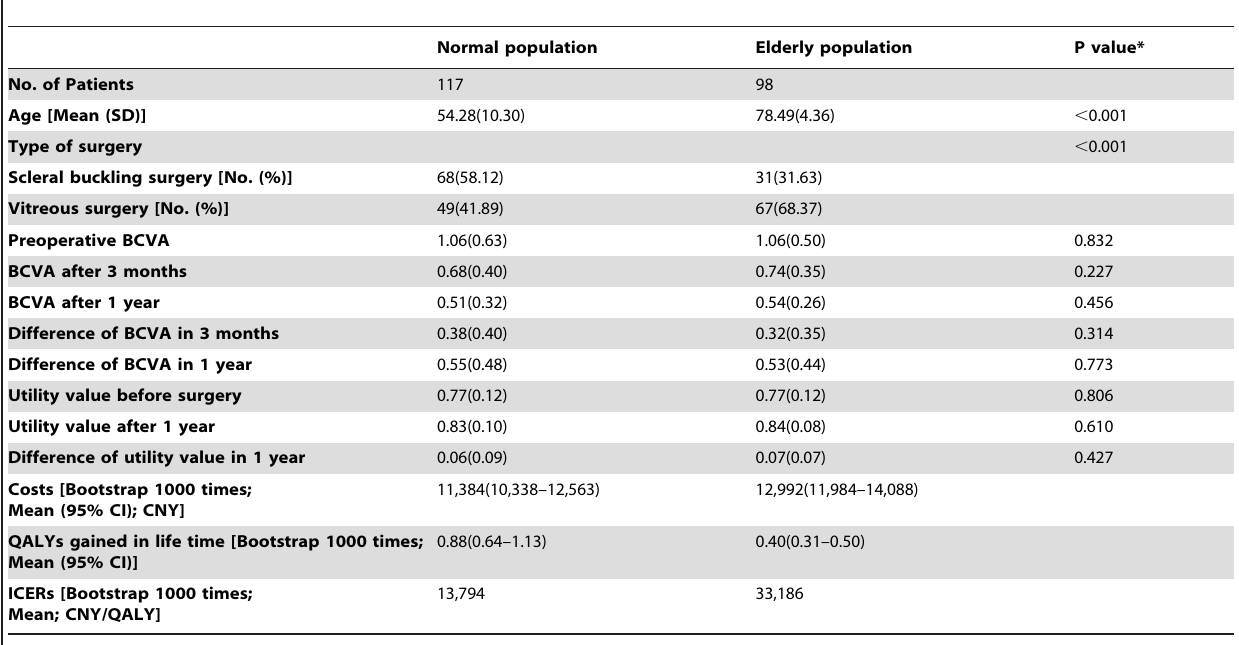
Table 7. Comparisons of surgical outcomes between the normal RRD patients and the elderly patients [4], [10].